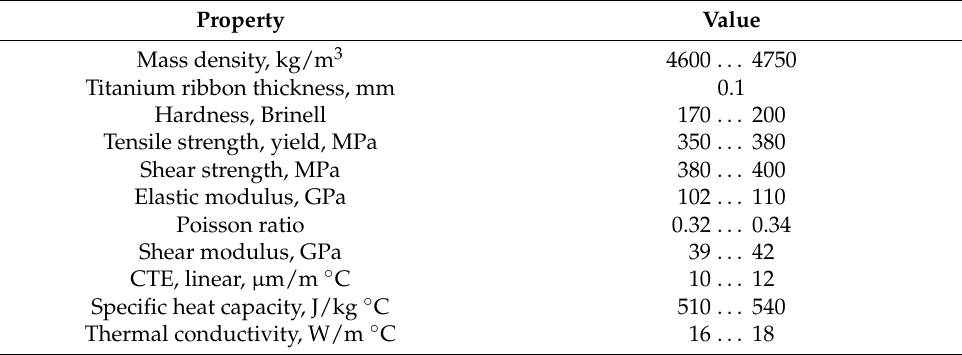
Table 4. Physical and mechanical properties of Ti layers VT1-0.